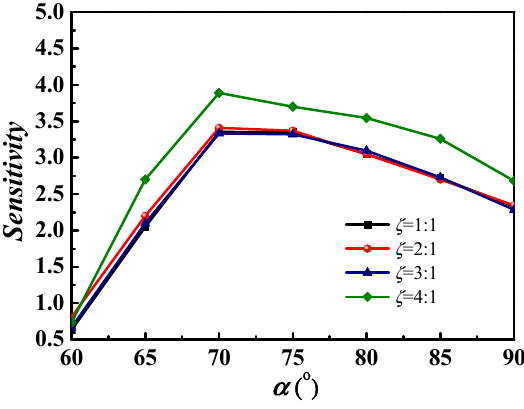
Figure 11. Sensitivity coefficient of magnetic direction on the Nu number with various cross-sections.